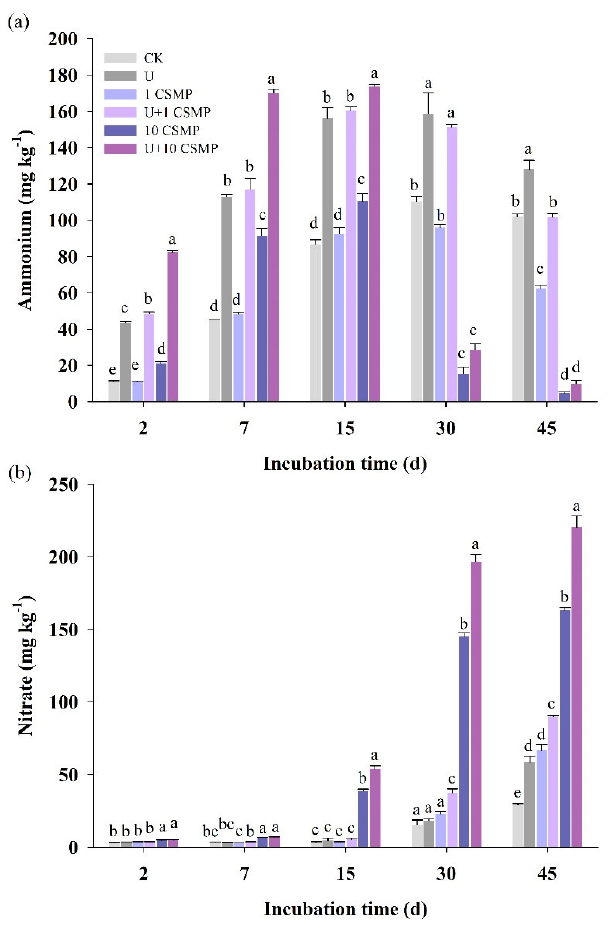
Figure 2. Soil ammonium ( a ) and nitrate ( b ) concentrations as affected by the amendment during the incubation. CK, no mineral amendments or urea; U, urea at 60 mg N kg − 1 soil; 1 CSMP, 1 g CSMP kg − 1 soil; U+1 CSMP, urea at 60 mg N kg − 1 + 1 g CSMP kg − 1 soil; 10 CSMP, 10 g CSMP kg − 1 soil; U+10 CSMP, 60 mg N kg − 1 + 10 g CSMP kg − 1 soil. Error bars represent standard error of the mean (n = 3). Different lowercases indicate significant differences among treatments ( p < 0.05).